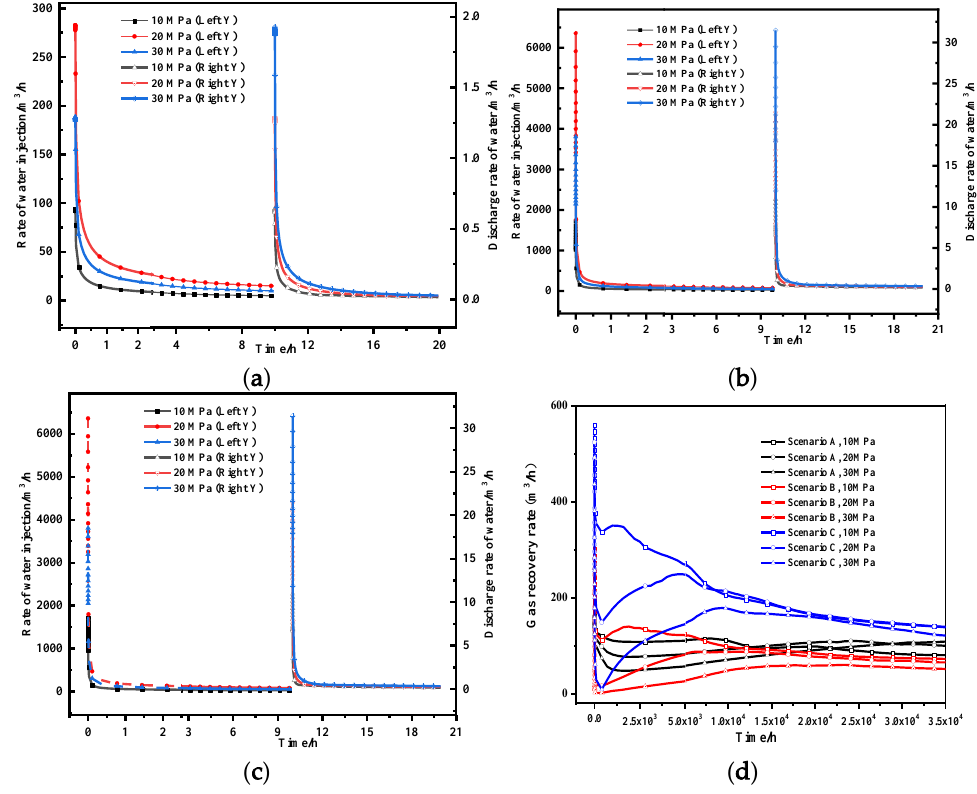
Figure 12. The water injection rate of (a) Scenarios A, (b) Scenario B, (c) Scenario C and (d) the gas production rate of the three scenarios.